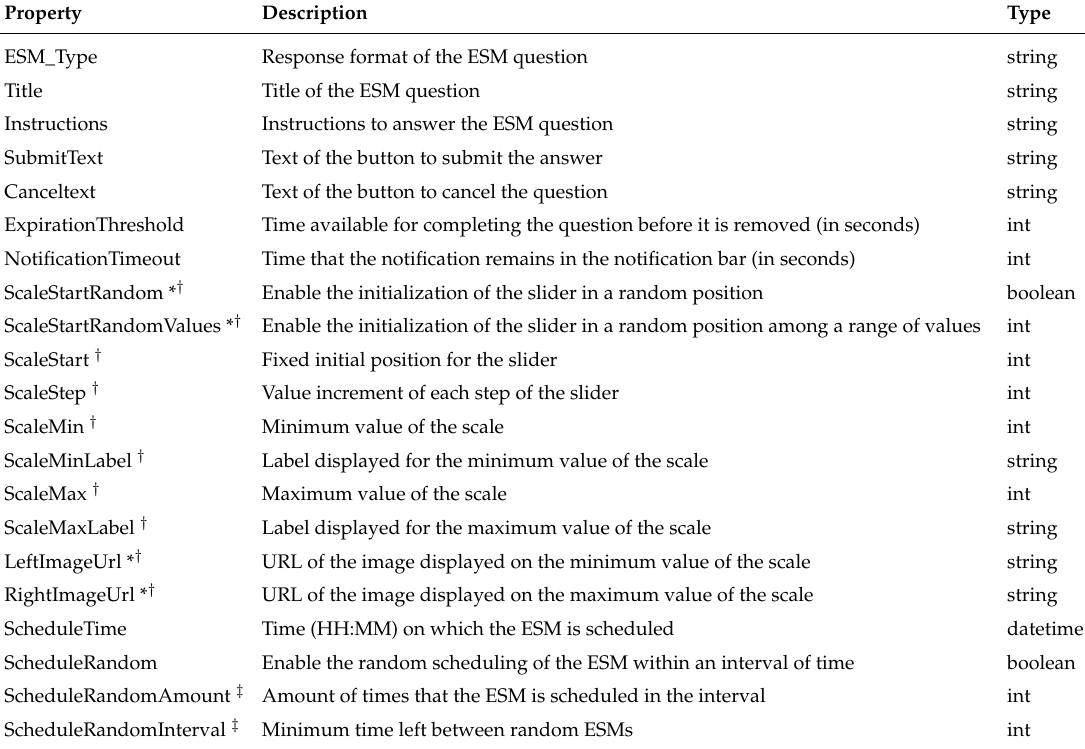
Table 1. Configurable properties of the ESMs within the Affective Flexible ESM